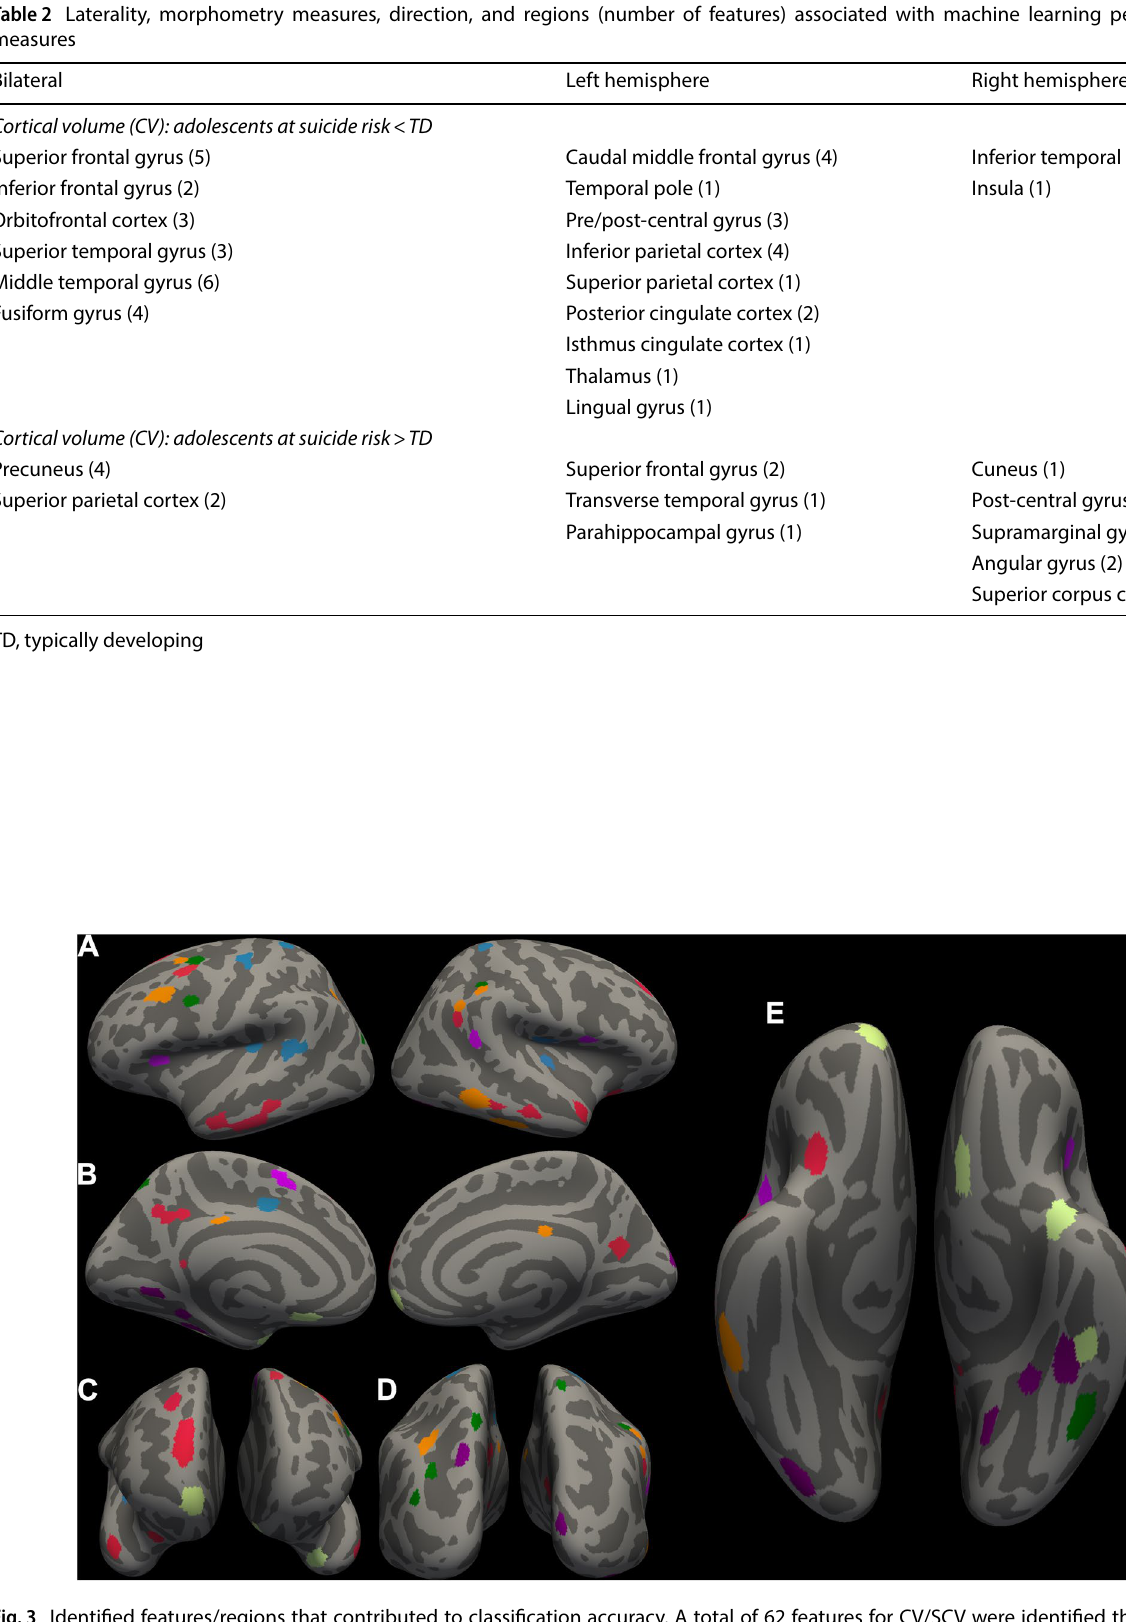
Fig. 3 Identified features/regions that contributed to classification accuracy. A total of 62 features for CV/SCV were identified that contrib- uted to the performance